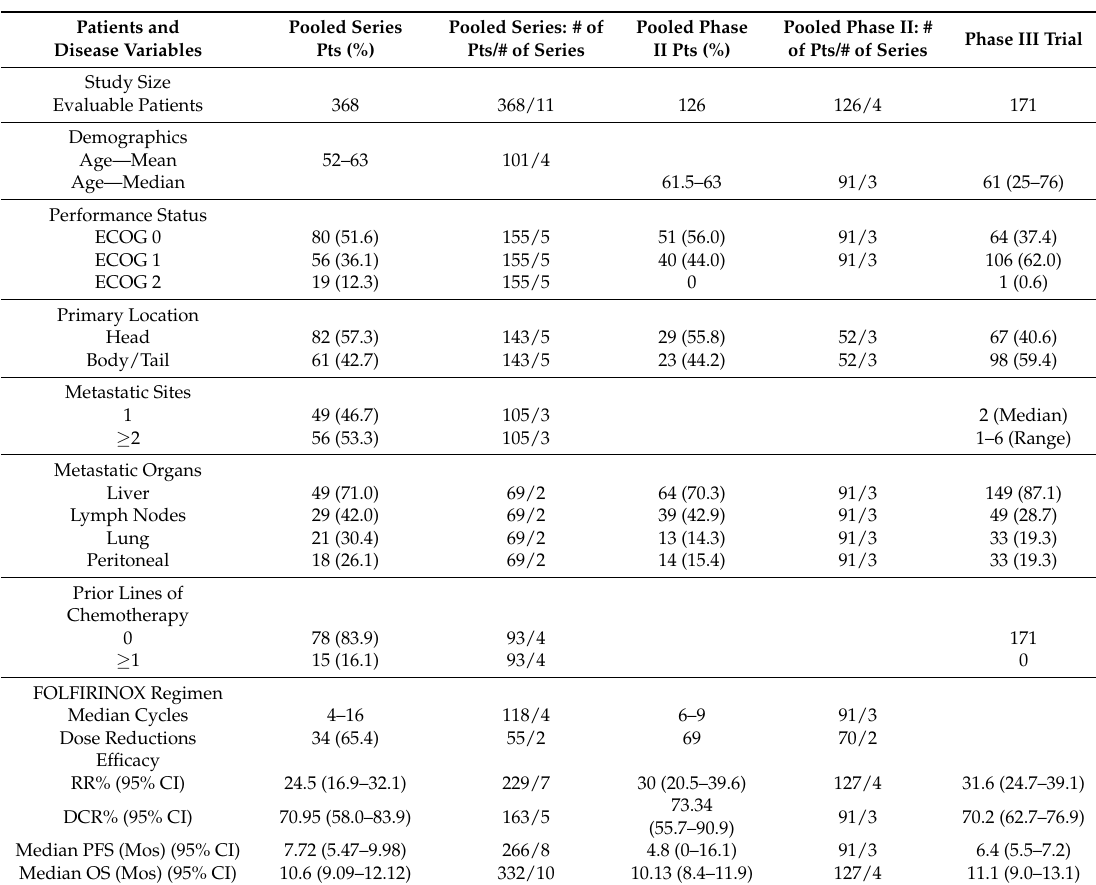
Table 3. Baseline characteristics and efficacy outcomes of patients included in the current pooled analysis of off-trial studies, the phase II studies, and the randomized phase III trial of FOLFIRINOX in metastatic pancreatic cancer. The third and fifth columns refer to the total number of patients and number of series on which the results depicted in the second and fourth columns, respectively, are based. Pts,